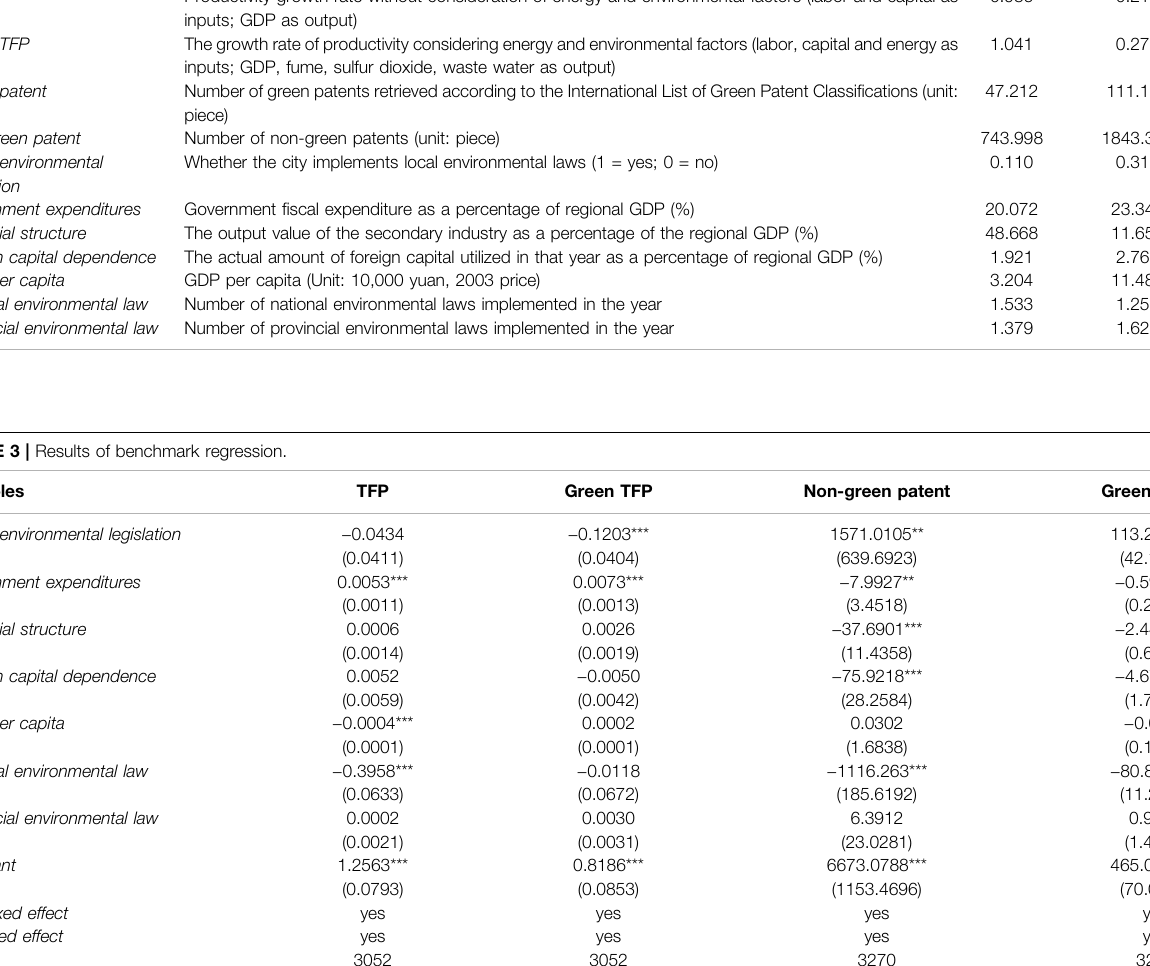
Non-green patent